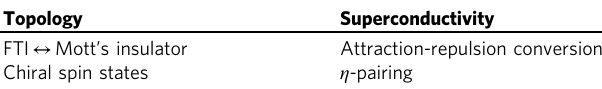
Table 1 Examples of Floquet-induced quantum phases for topological and superconducting